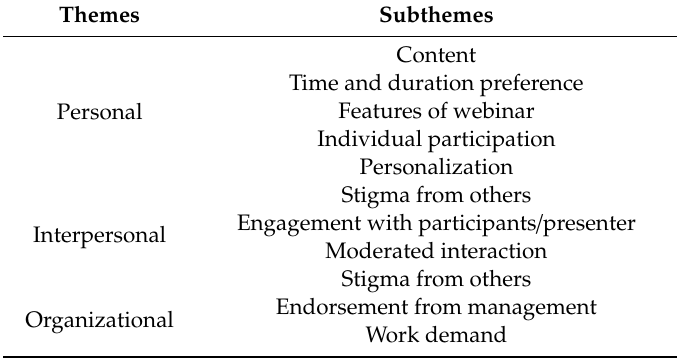
Table 3. Themes and